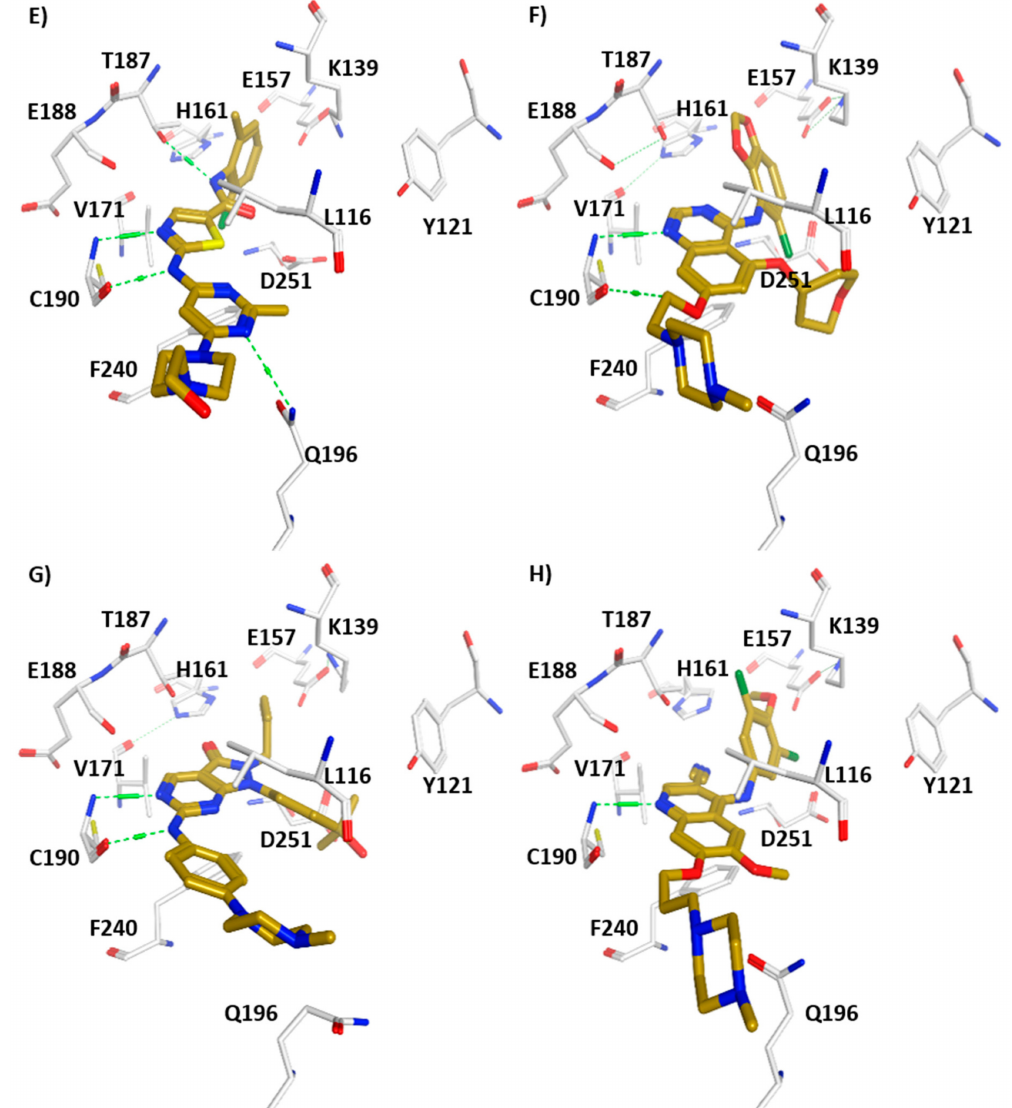
Figure 3. Interaction of WEE1 and PKMYT1 inhibitors observed in reported crystal structures. Hydrogen bonds with hinge region residues are displayed as dashed green lines. ( A ) Superposition of the X-ray structures of WEE1 in complex with pyrrolocarbazoles and pyrroloindoles (colored magenta); ( B ) WEE1 in complex with the diaminopyrimidine derivative MK1775 (colored cyan, PDB ID: 5V5Y); ( C ) WEE1 in complex with the pyridopyrimidine derivative PD-0166285 (colored cyan, PDB ID: 5VC5); ( D ) WEE1 in complex with Bosutinib (colored cyan, PDB ID: 5VC3); ( E ) PKMYT1 in complex with Dasatinib (colored yellow, PDB ID: 5VCV); ( F ) PKMYT1 in complex with Saracatinib (colored yellow, PDB ID: 5VCX); ( G ) PKMYT1 in complex with the diaminopyrimidine derivative MK1775 (colored yellow, PDB ID: 5VD0); ( H ) PKYMT1 in complex with the 4-aminquinoline derivative Bosutinib Isomer (colored yellow, PDB ID: